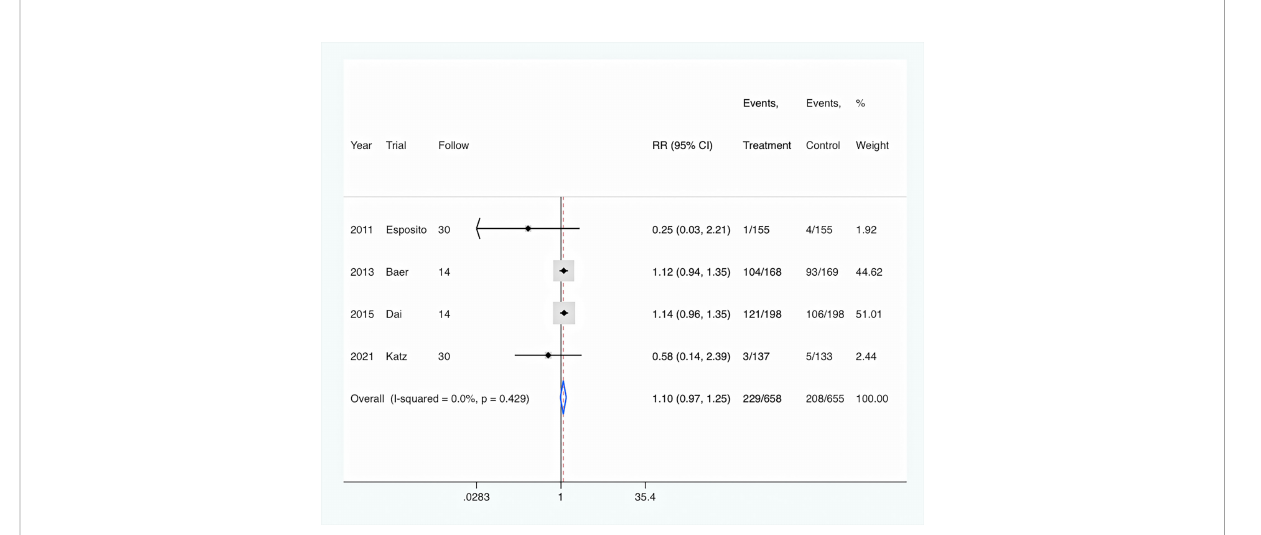
FIGURE 5 PCT-guided treatment was associated with similar rate of antibiotics prescription.